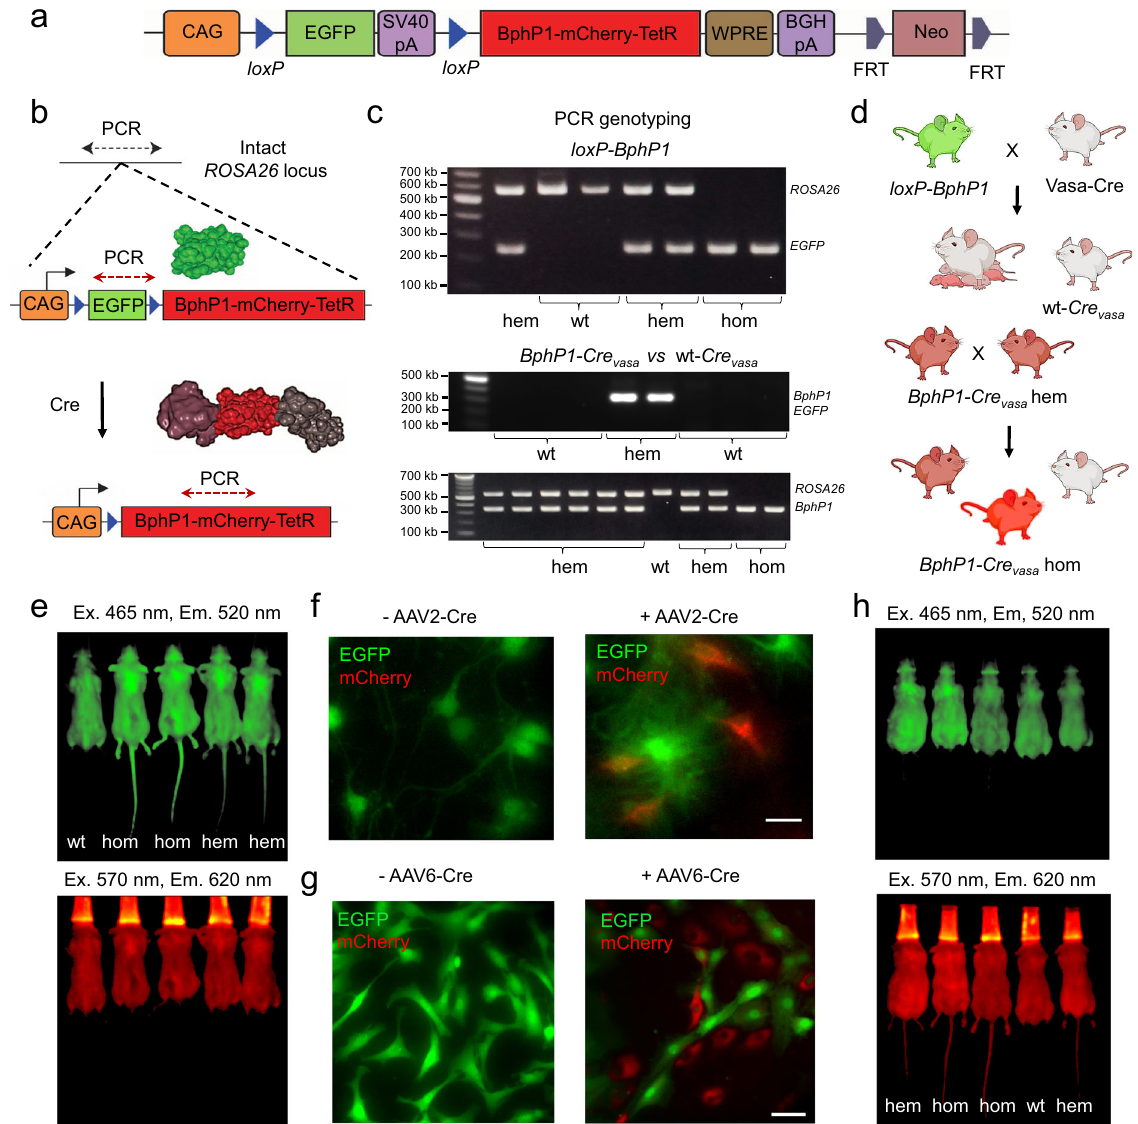
Fig. 1 Generation of loxP-BphP1-mCherry-TetR knock-in mice and Cre-dependent BphP1 expression. a Transgene elements: CAG, CAG promoter; loxP , locus of X-over P1, Cre-recombinase recognition site; SV40pA, simian virus 40 polyadenylation signal; TetR, tetracycline repressor protein; WPRE, Woodchuck Hepatitis Virus (WHP) Posttranscriptional Regulatory Element; BGHpA, bovine growth hormone polyadenylation signal; FRT, fl ippase recognition target site; Neo, neomycin resistance cassette. b Targeting of BphP1 gene into ROSA26 locus and Cre-dependent expression of BphP1-mCherry-TetR protein. c PCR genotyping of loxP - BphP1 and BphP1-Cre vasa mice using primers annealing to intact ROSA26 locus (5 ′ -AGCACTTGCTCTCCCAAAGTC, 5 ′ -TGCTTACATAGTCTAACTCGCGAC, product size 564bp), transgene EGFP sequence (5 ′ -GGCAGAGGATCGTTTCGCGG, 5 ′ -GAAGCACTGCACGCCGTAGG, product size 240bp) and BphP1 sequence (5 ′ -GAG CGCGTCCACACCGTTAC, 5 ′ -GGCAACATGTCGCGGAACGA, product size 341bp). Genotypes indicated: hom, homozygote; hem, hemizygote; and wt, wild-type. d Hemizygous loxP-BphP1 males were crossed with Cre-driver (Vasa-Cre) strain females of ubiquitously active Cre, and subsequent generations of homozygous BphP1-Cre loxP-BphP1 mice using IVIS Spectrum instrument. Top: EGFP fl uorescence. vasa mice were obtained. e In vivo imaging of the progeny of hemizygous Bottom: mCherry fl uorescence. f Cre recombination in primary hippocampal neurons isolated from homozygous loxP-BphP1 mouse and transduced with AAV2-Cre, fl uorescence images 7 days after transduction. Scale bar, 20 μ m. g Cre recombination in primary skin fi broblasts isolated from hemizygous loxP-BphP1 mouse, epi fl uorescence images 7 days after transduction with AAV6-Cre. Scale bar, 50 μ m. h IVIS Spectrum in vivo imaging of the progeny of hemizygous loxP-BphP1 mice and hemizygous Vasa-Cre mice vs homozygous BphP1-Cre vasa mice. Top: EGFP fl uorescence. Bottom: mCherry fl uorescence. For more details, see “ Statistics and reproducibility ” section of the Fibroblasts were transduced with adeno-associated virus serotype homozygous mice, which displayed higher EGFP fl uorescence 6 (AAV6) encoding Cre recombinase under the CAG promoter (Fig. 1e). (AAV6 enables high-ef fi ciency transduction of fi broblasts 28 ), while primary hippocampal neurons were transduced with AAV2-CAG-Cre viral particles. Fluorescence imaging performed Cre-dependent expression of BphP1-mCherry-TetR in primary 7 days after transduction (Fig. 1f, g) demonstrated that a portion cells . Primary fi broblasts and neurons were further used to test of cells has lost EGFP and gained mCherry fl uorescence, Cre-dependent excision of loxP - fl anked EGFP coding sequence.